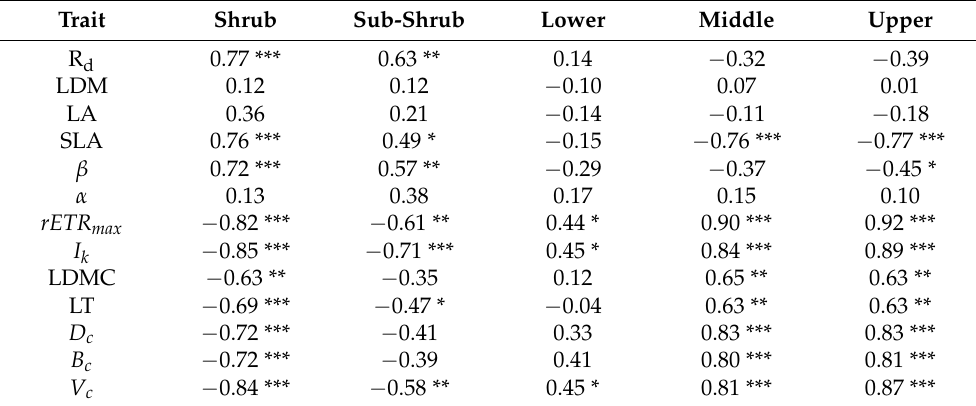
Figure 4. Canopy trait differences among height groups. Differences in each trait were checked us- ing the Tukey test at a 95% family − wise confidence level. HG refers to the higher height group, comprising Machilus breviflora , Schima superba , and Castanopsis chinensis; MG refers to the middle The five height ranges were: shrub canopy (1.4–4 m); sub-shrub canopy (4–6.8 m); lower canopy (6.8–11.3 m); height group, comprising Cryptocarya concinna and Cr . chinensis; LG refers to the lower height group, middle canopy (11.3–17.4 m); upper canopy (17.4–27.1 m). R d : the rate of leaf dark respiration; LDM: leaf